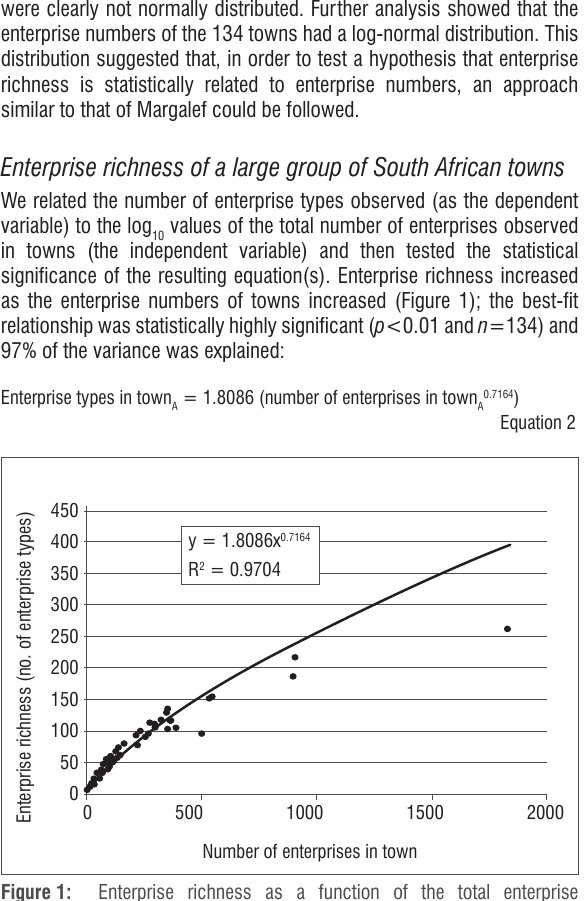
African provinces (Table 1) and represented a large subset of South African towns.